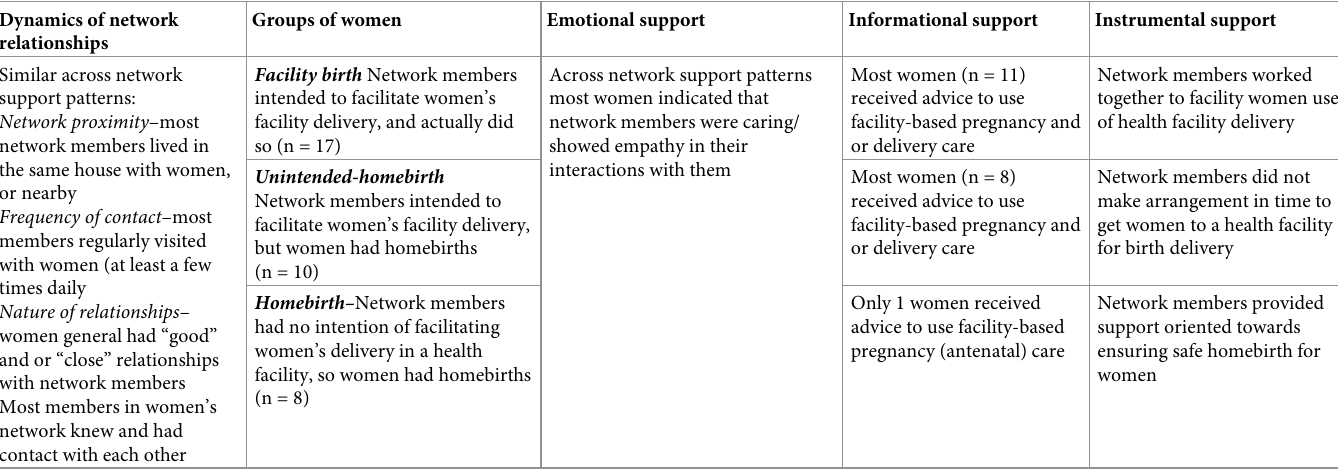
Table 3. Social support and network composition among three groups of women that had either health facility of homebirth. Dynamics of network